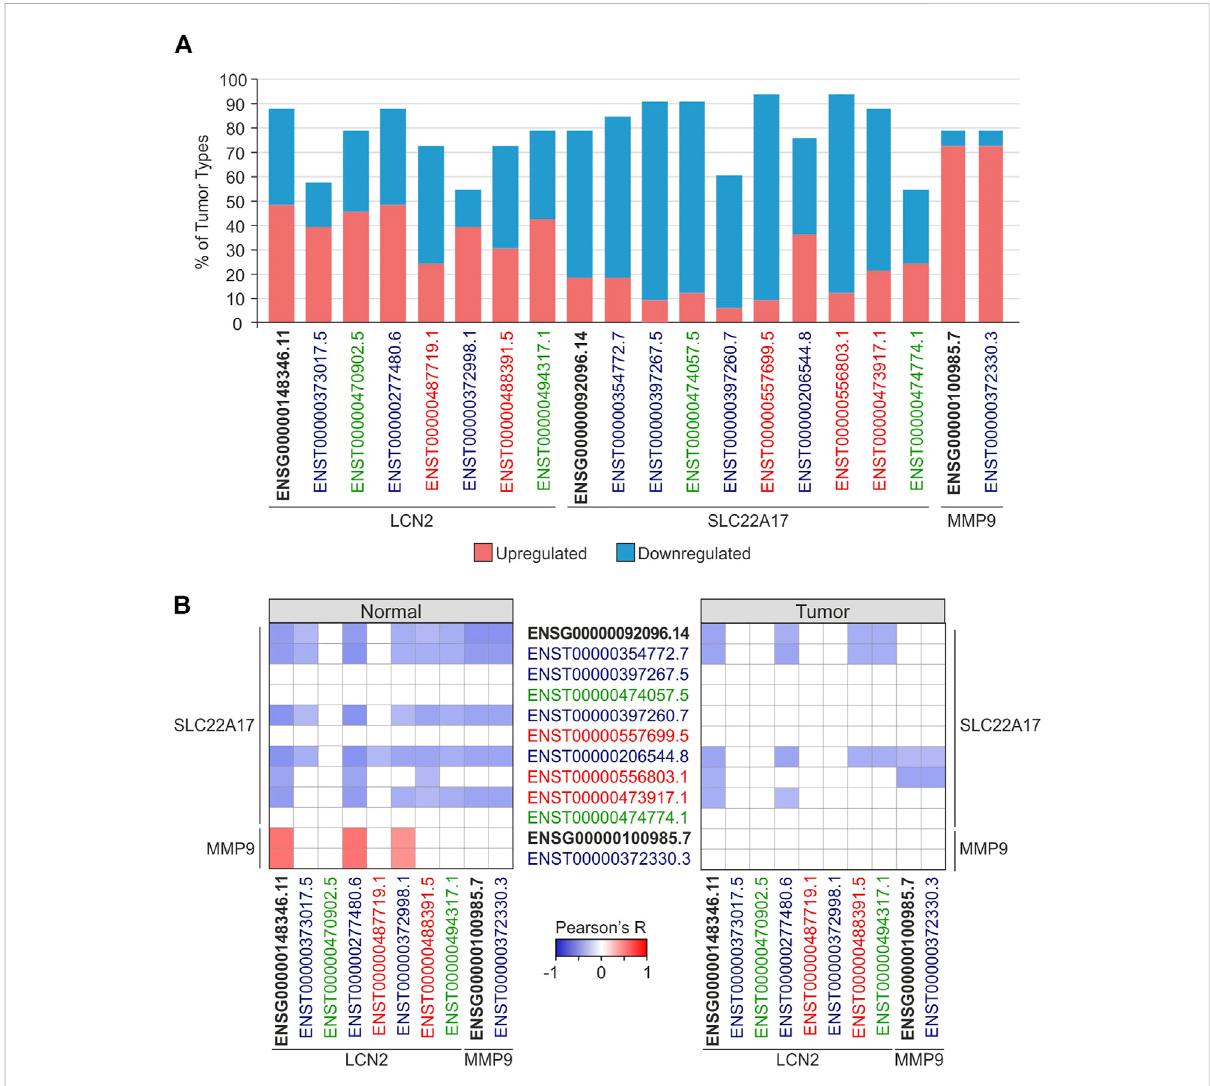
FIGURE 3 Expression and correlation analyses of gene (ENSG) and splicing isoforms(ENST) ofLCN2, SLC22A17, and MMP9 innormal and tumoral tissues. (A) Percentage of tumor types in which LCN2 , SLC22A17 , and MMP9 expression levels were up (red) or downregulated (blue) compared to normal tissues. Only tumors showing FC ≥ 1.4 or ≤ − 1.4 ( p ≤ 0.05) are included in the analysis. (B) Correlation analysis between LCN2 , SLC22A17 , and MMP9 genesandisoformsexpressioninnormalandtumorsamples.Tumorandnormalsampleswereanalyzedcollectively.CorrelationwithPearson ’ s r ≥ 0.3 or ≤ − 0.3 and p ≤ 0.05 were included in the heatmap. Black bold labels indicate the LCN2 , SLC22A17 , and MMP9 genes (ENSG). Coding ENST isoforms: blue; non-coding ENST isoforms: green; retained intron ENST isoforms: